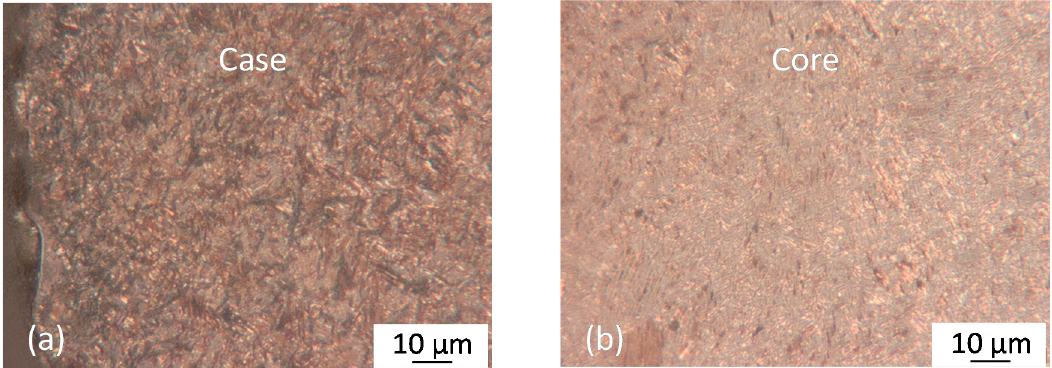
Figure 7. Chemically etched microstructure of as-built and case-hardened specimen ( a ) and grain-coarsened and case-hardened specimen in the core region ( b ). Used additive manufacturing parameters: P L = 300 W; H = 40 µm, h = 120 µm, v s = 850 mm/s.